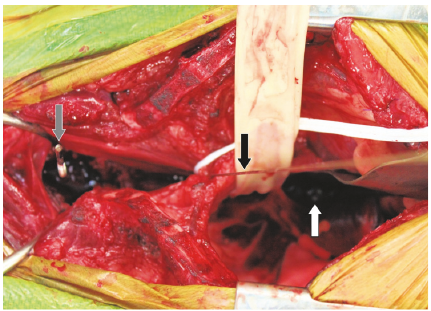
Figure 4: Intraoperative image. String-of-Pearls plate (white arrow) placed along ventral spine held in place with a Kirschnerwire (black arrow). Grey arrow denotes a drill bit left in place to check depth with fluoroscopy.